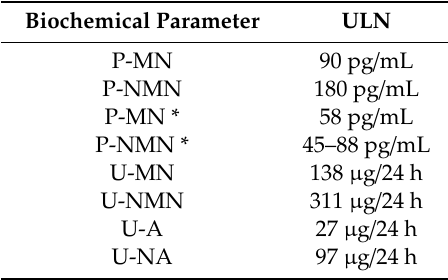
Table 1. Upper limits of normal (ULN) of the metabolites as used in the analyses of this study. Biochemical